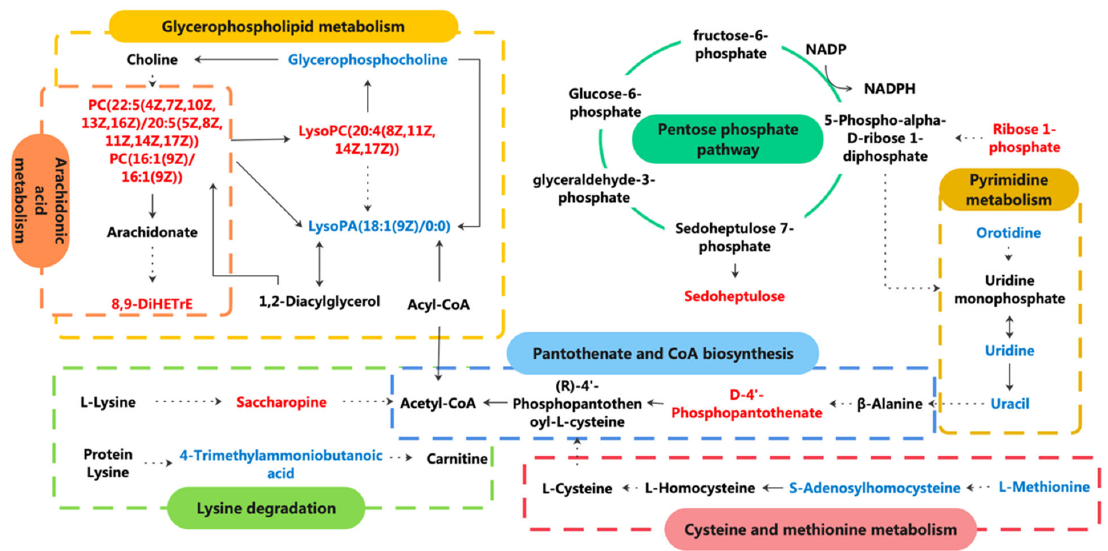
Figure 12. Comprehensive metabolic pathway analysis of potential biomarkers from